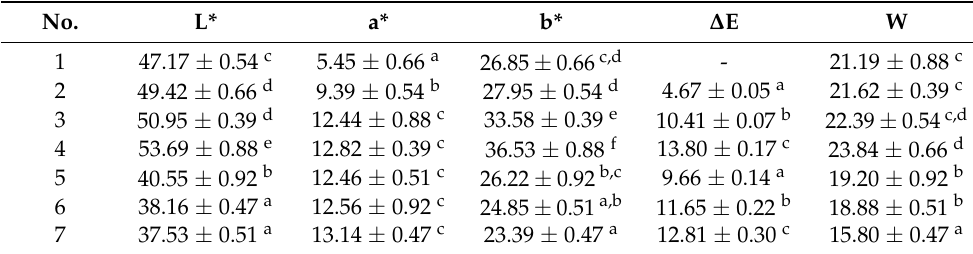
Table 5. Color of muffins with Lyo apple and OT+Lyo